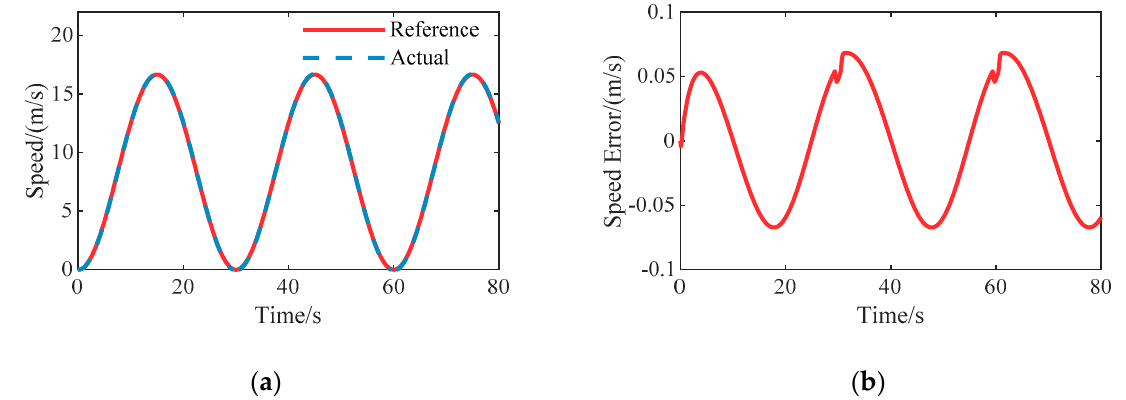
Figure 6. System responses to sinusoidal reference speed on the straight road: ( a ) Speed tracking results; ( b ) The resulting speed tracking error.